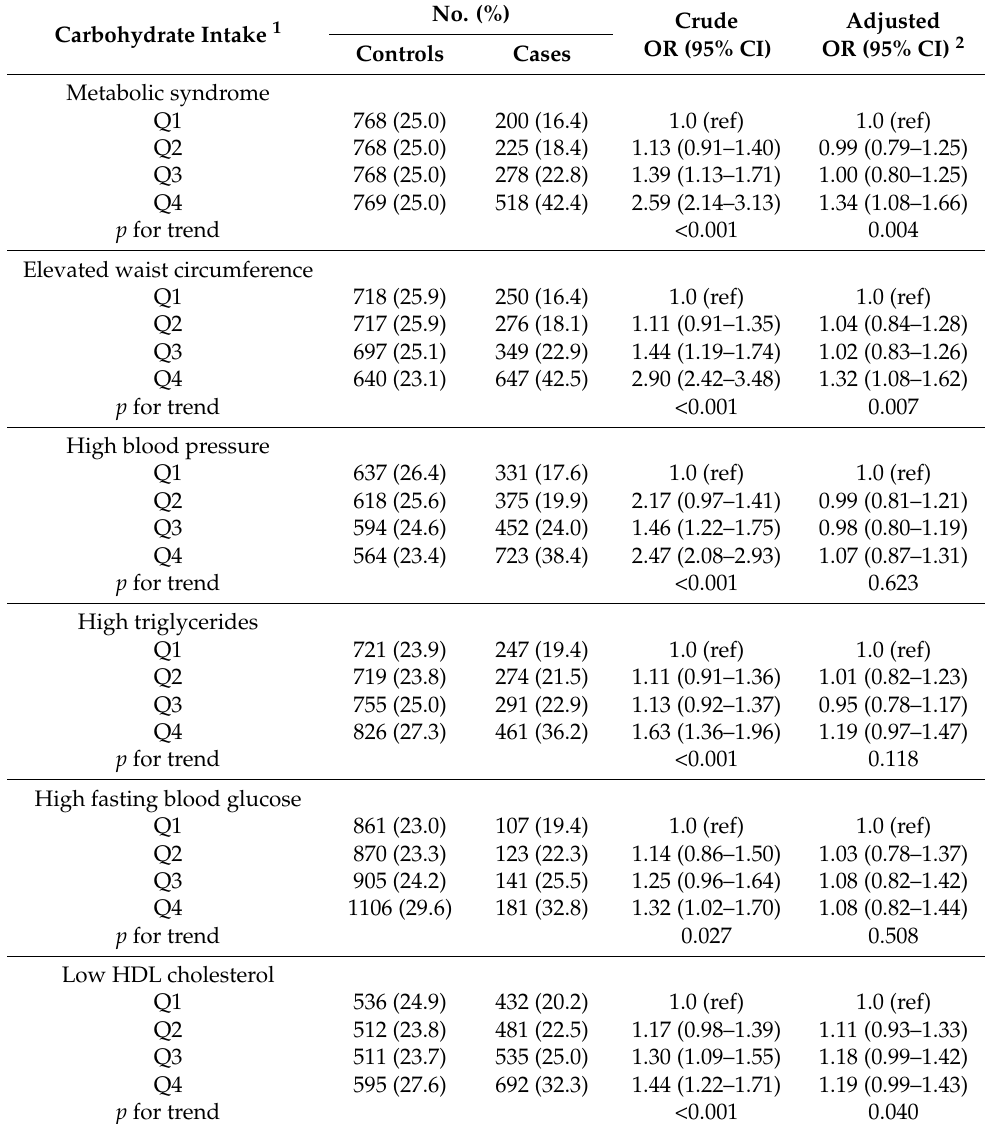
Table 1. Association of carbohydrate intake with the risk of metabolic syndrome and its